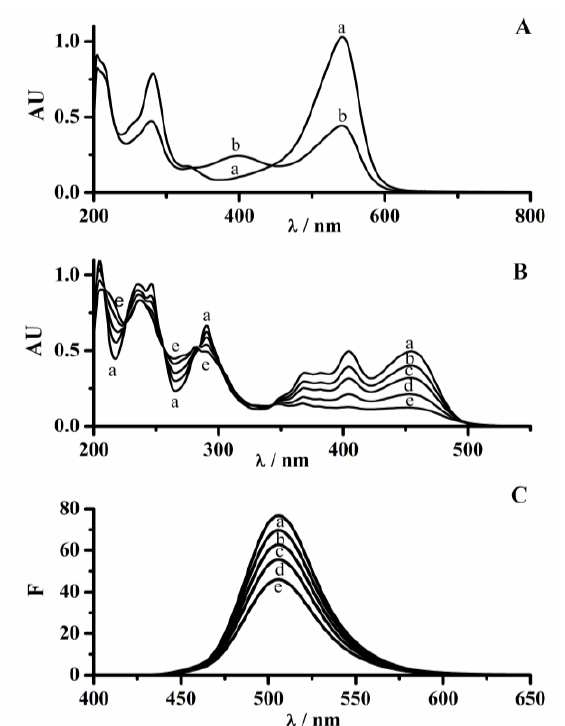
Figure 1. Probe spectroscopic changes induced by HOCl. ( A ) Changes in the UV-visible spectrum of PGR (30 µM) induced by hypochlorite (15 µM). Line a and b before and